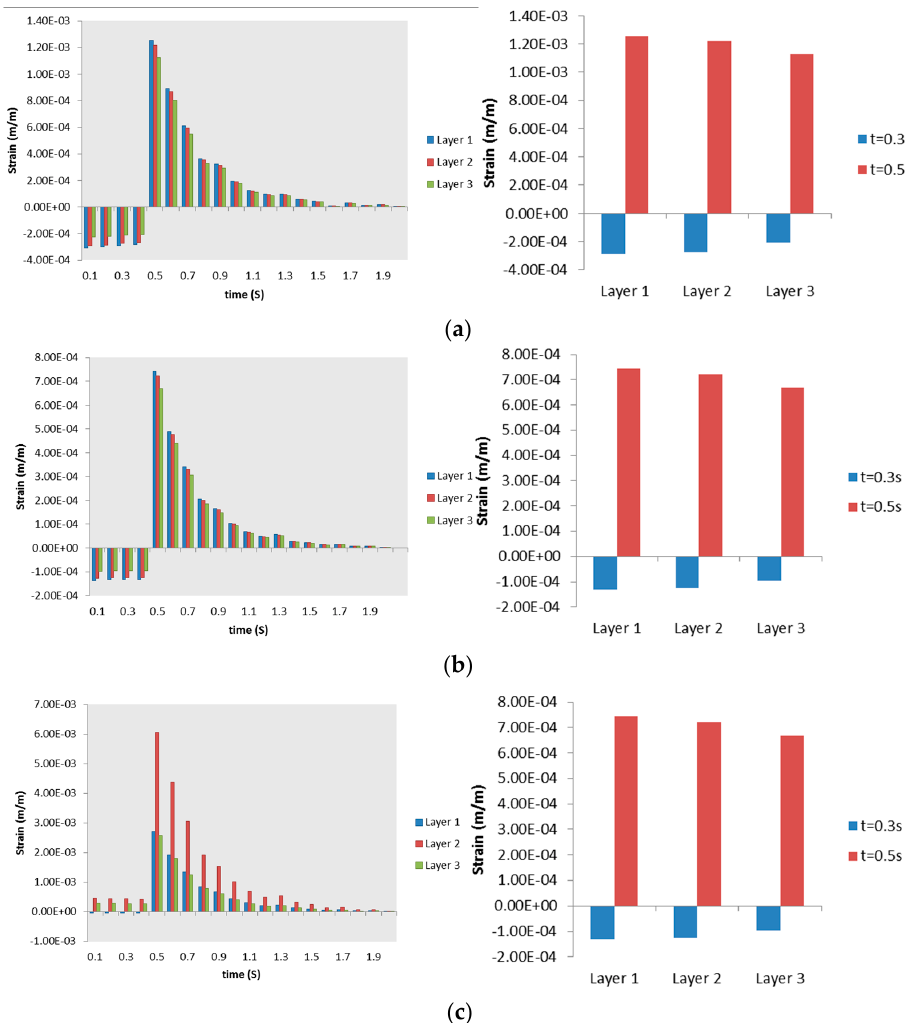
Figure 9. Maximum Von Mises strains occurring in ( a ) Section 1; ( b ) Section 2; and ( c ) Section 3. Right column shows strain progression over time, left column captures the Von Mises strain at specific time for a clearer comparison.